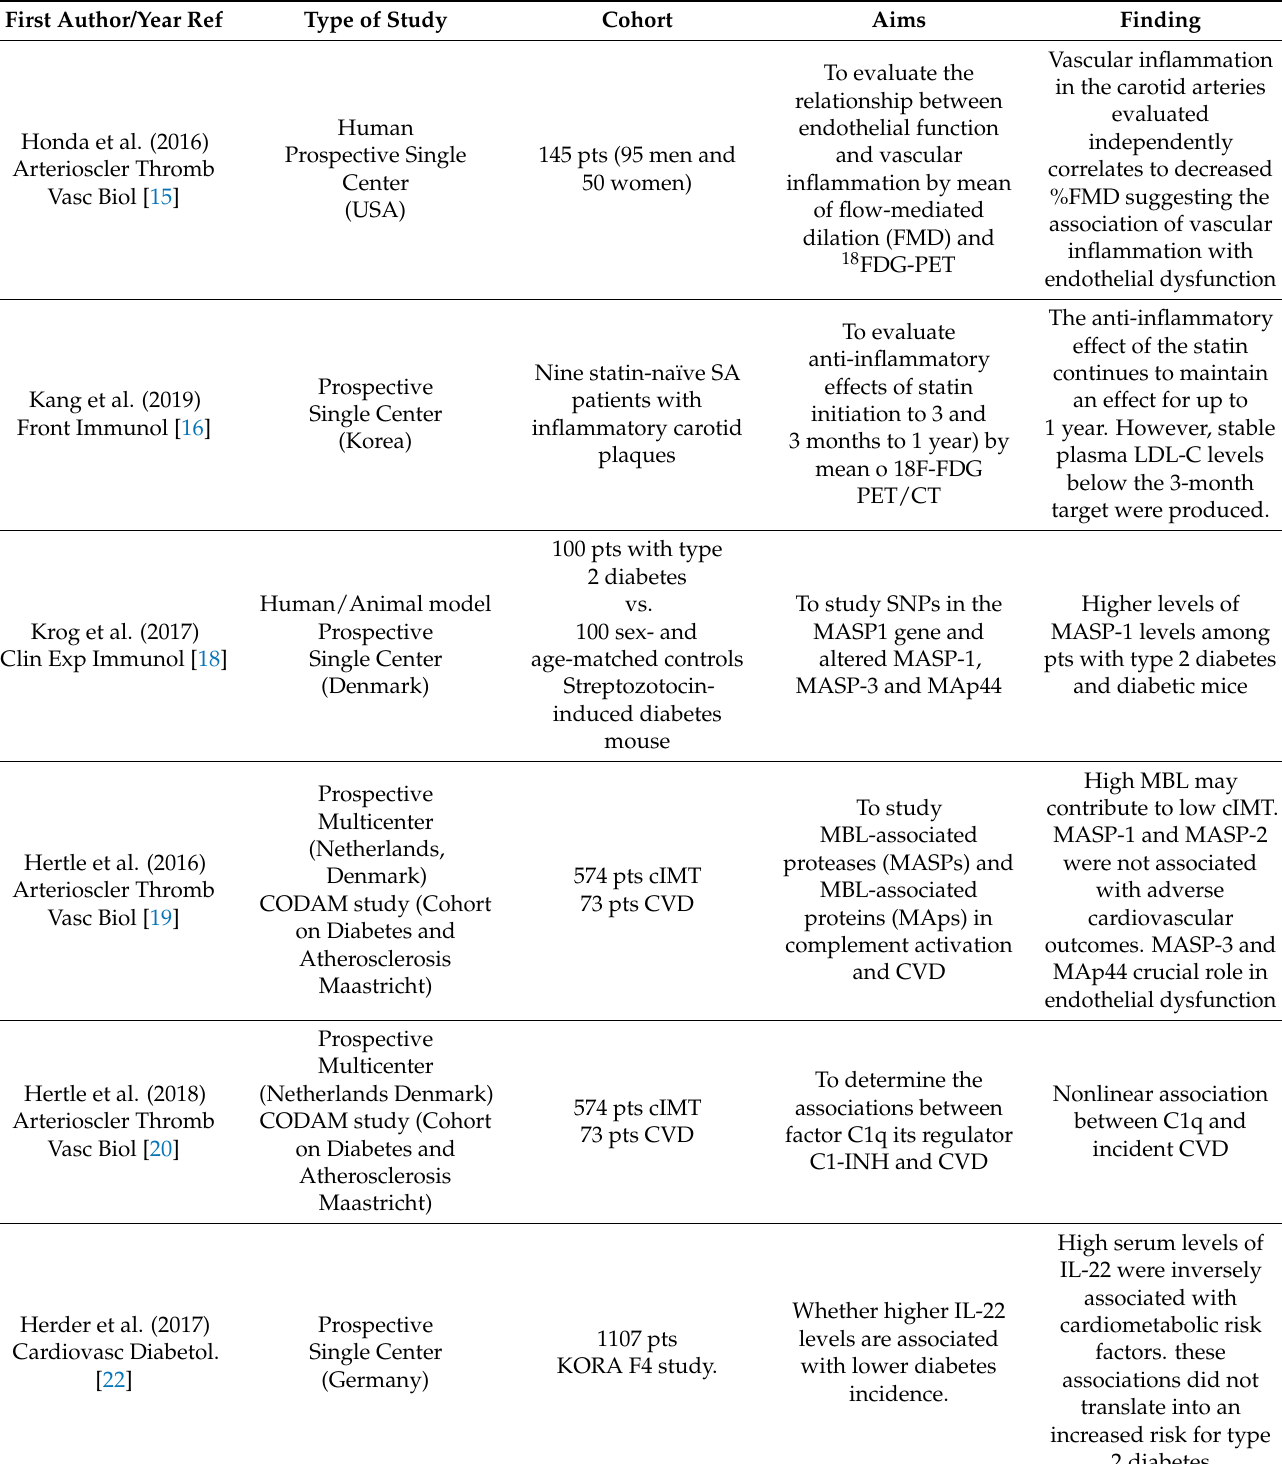
Table 1. Characteristics of the Included